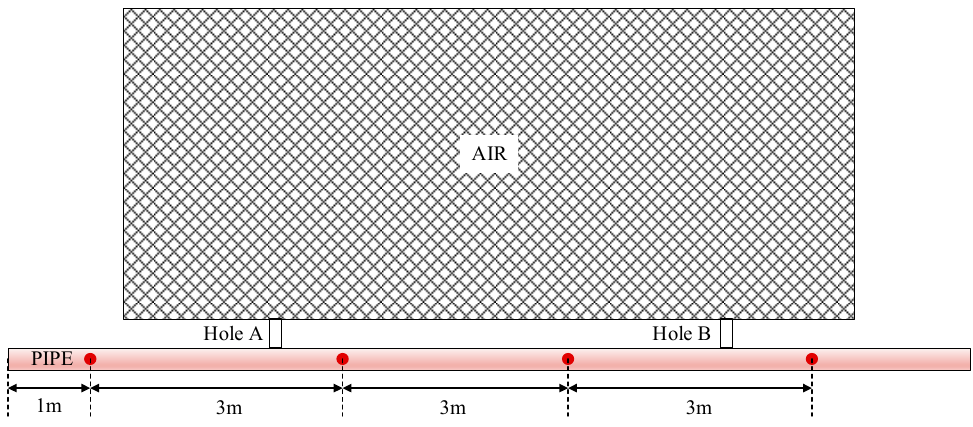
Figure 1. Schematic diagram of the two-dimensional simulation model. A 2D structured mesh was generated from the geometric model. Due to the large pressure gradient at the leakage point, the local grid was encrypted. To truly restore the flow state of the fluid at the leakage hole when the valve is opened or closed, dynamic mesh technology was used to simulate the valve transition. At first, valve A was closed, as shown in Figure 3a, and the fluid in the pipe flowed normally into a stable state. At 3